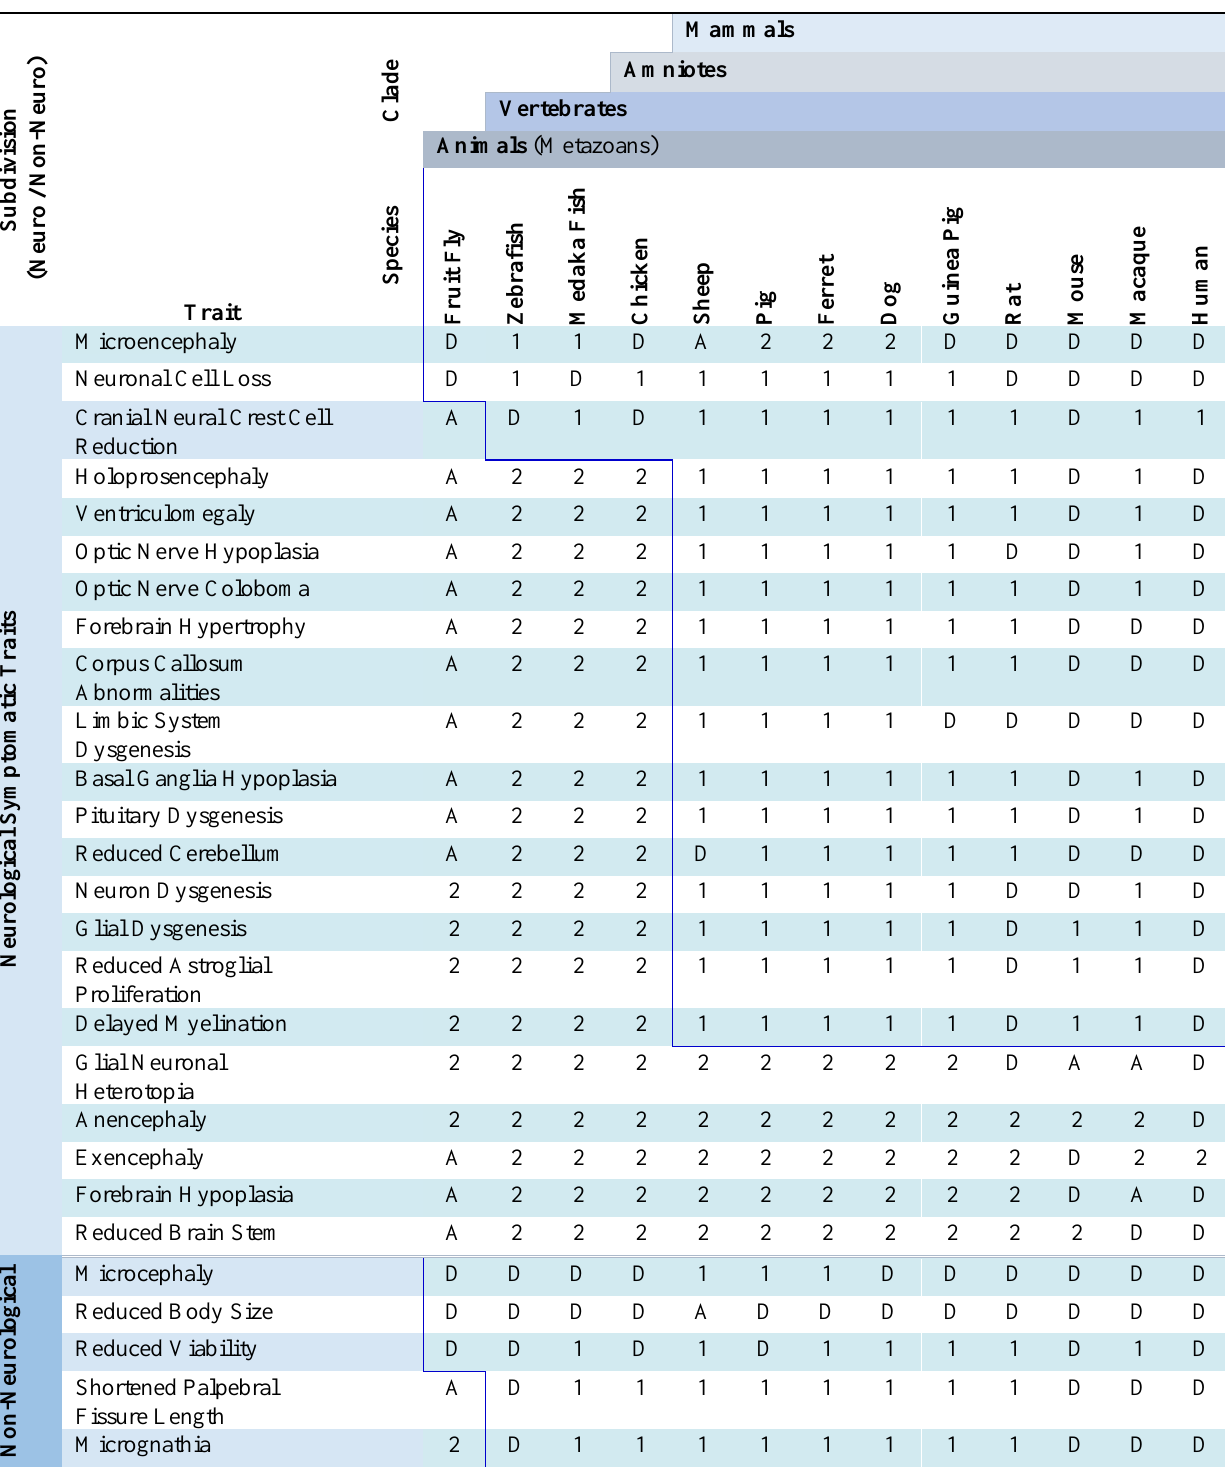
Table 3. FASD. Documented and inferred character states for symptomatic traits among model FASD Animals. Blue line indicates phylogenetically lower-level limits of Level 1 inferences (highest confidence) or Documented symptoms. Key: D = documented symptom; A = documented absent symptom; 1 = Level 1 inference; 2 = Level 2 inference. Data were extracted from sources indicated (**) in the